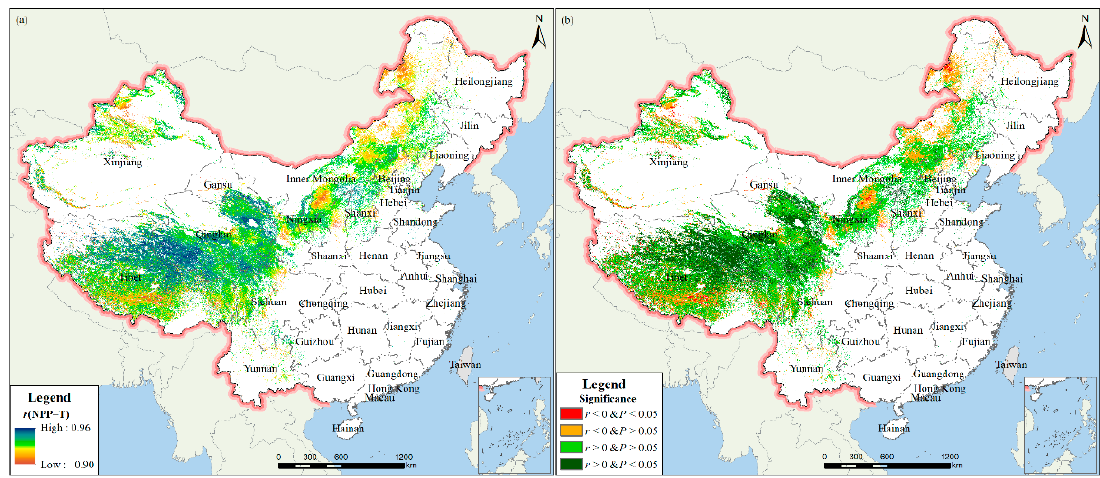
Figure 14. Spatial patterns of ( a ) partial correlation coefficients between ANPP and annual average temperature and ( b ) the corresponding significance levels.